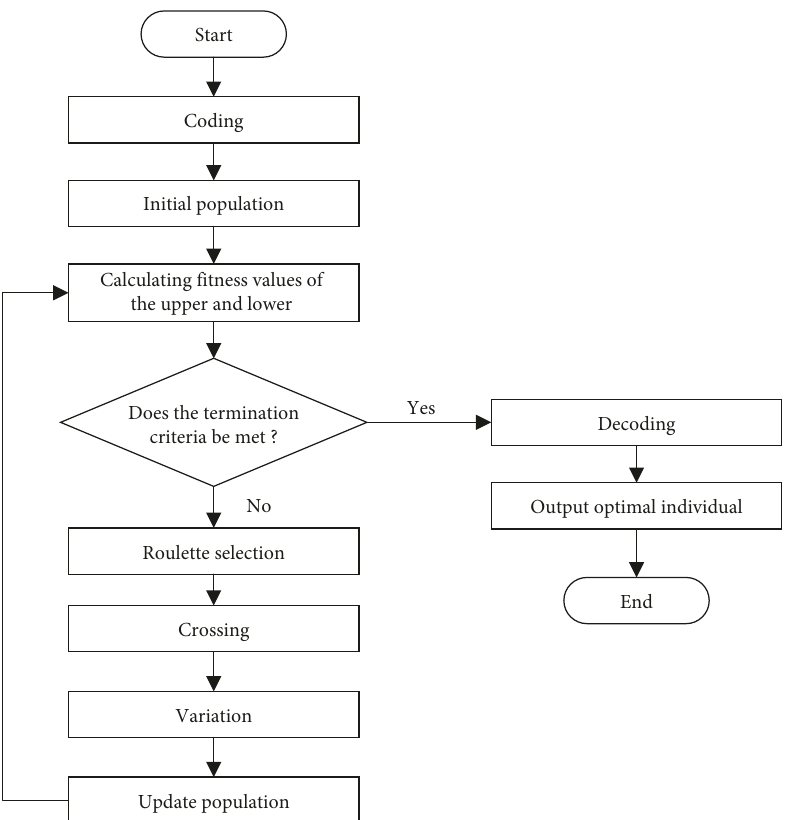
Figure 5: Basic flow chart of hybrid genetic